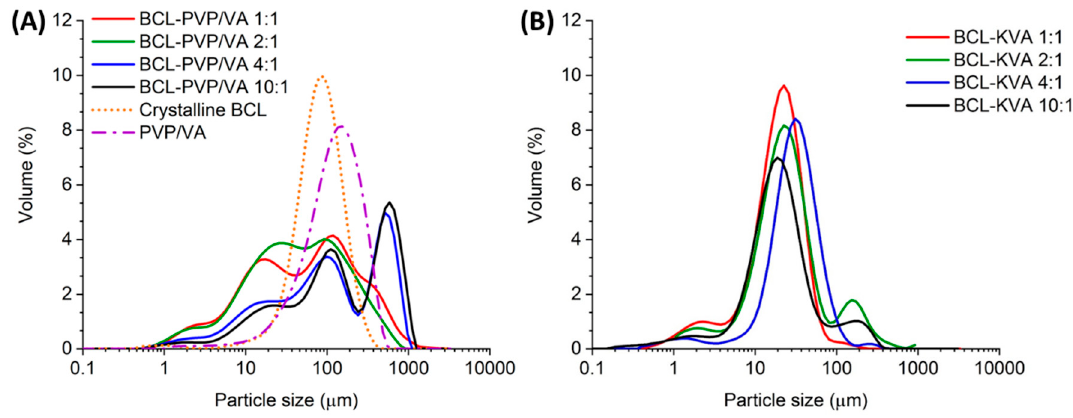
Figure 2. Particle size distribution of BCL-PVP / VA solid dispersions obtained by either ball milling ( A ) or spray drying ( B ). Table 2. Particle size of solid dispersions obtained using the laser di ff raction